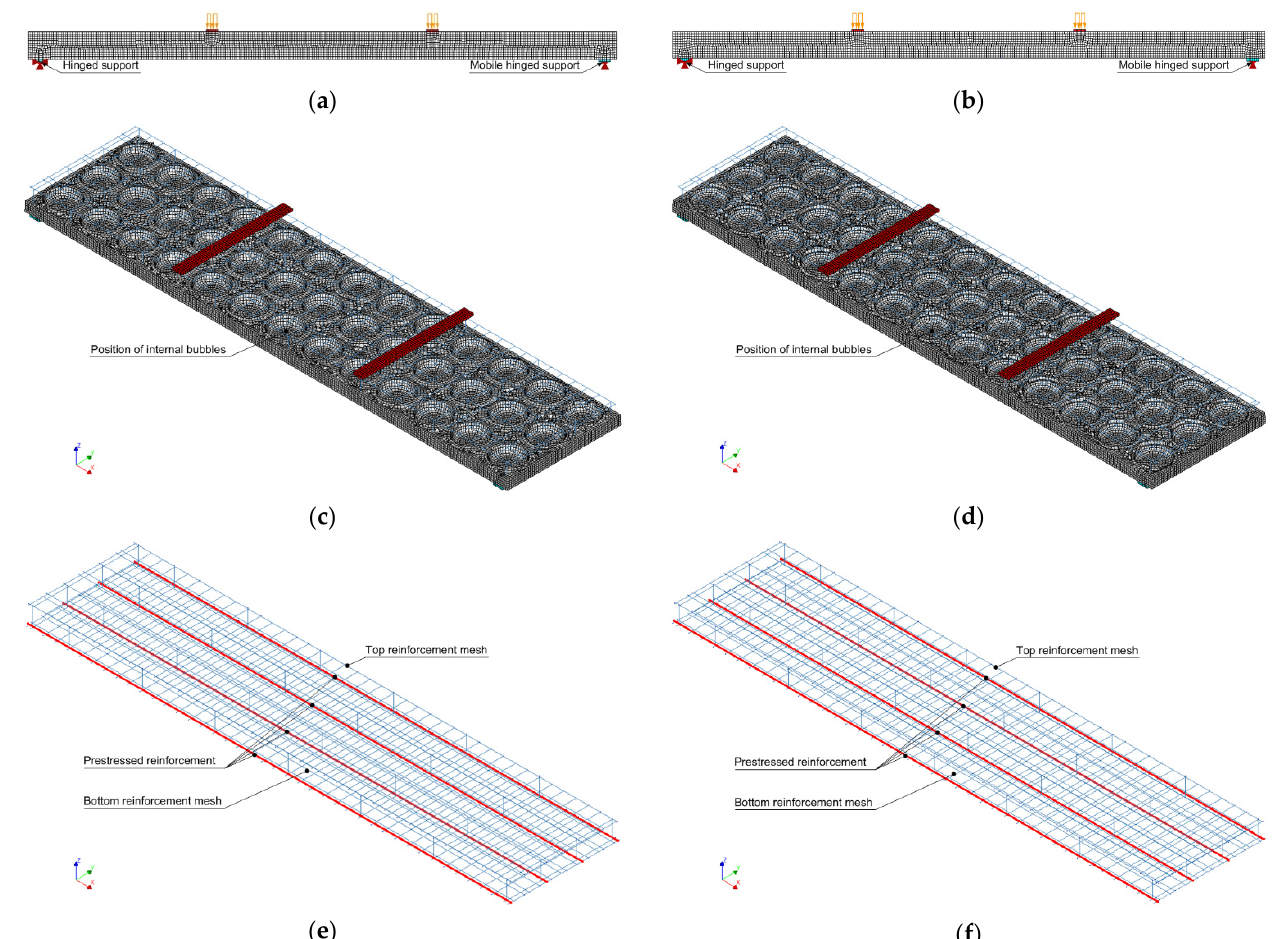
Figure 18. Views of modelled slabs: ( a , b ) supporting and loading of slabs I pl and II pl; ( c , d ) positions of voids in slabs 1 and 2; ( e , f ) reinforcement in the model of slab 1 and 2.